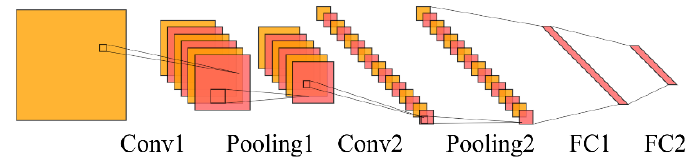
Figure 3. The structure of CNN.